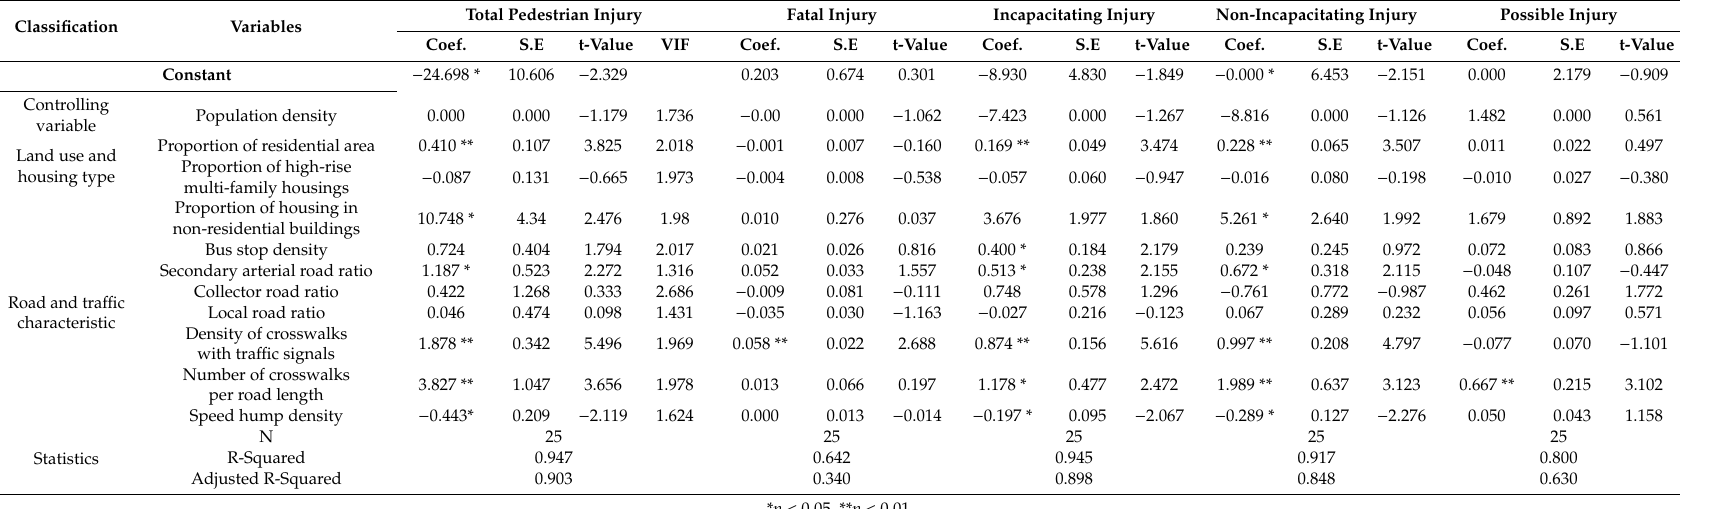
Table 4. Model estimation results for pedestrian injury